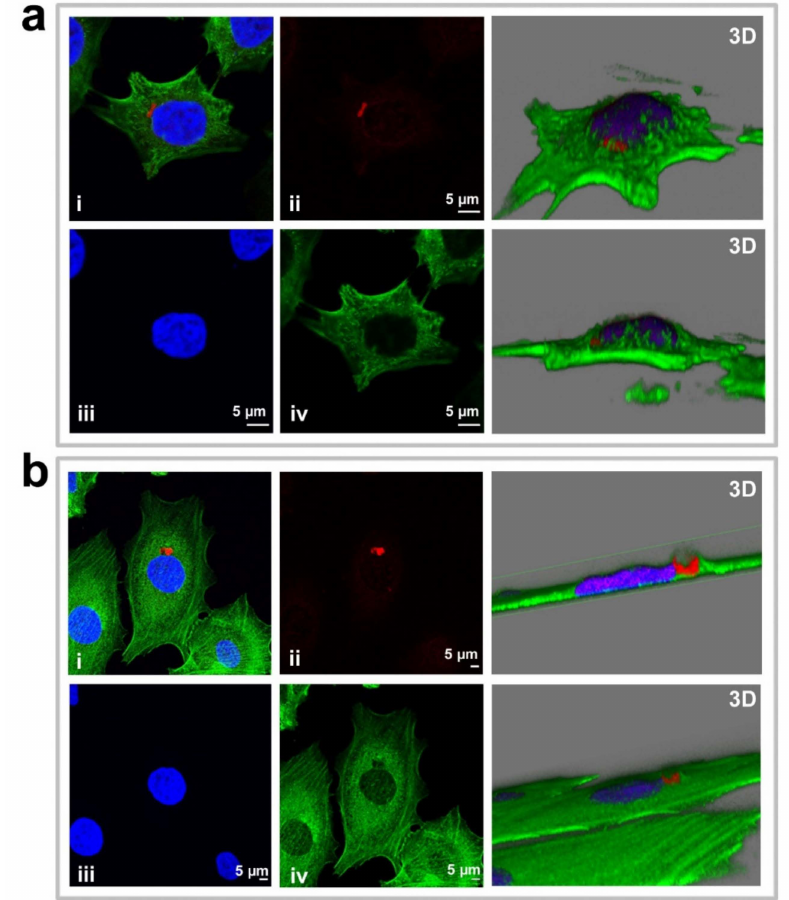
Figure 6. Confocal laser scanning microscope images of AuNCs localization in MCF7 cells after 3–4 h of incubation. Panel a shows an example of AuNCs cellular internalization while panel b shows AuNCs layered outside, on top of the cells. The left side of the panel corresponds to 2D images (one section or focal plane) for the merge (i), AuNCs in red (ii, Ex.405 / Em.680 nm), nucleus with DAPI in blue (iii, Ex.358 / Em.461) and actin filaments labeled with Phalloidin in green (iv, Ex.495 / Em.519 nm) while the right side shows the 3D reconstructions of those